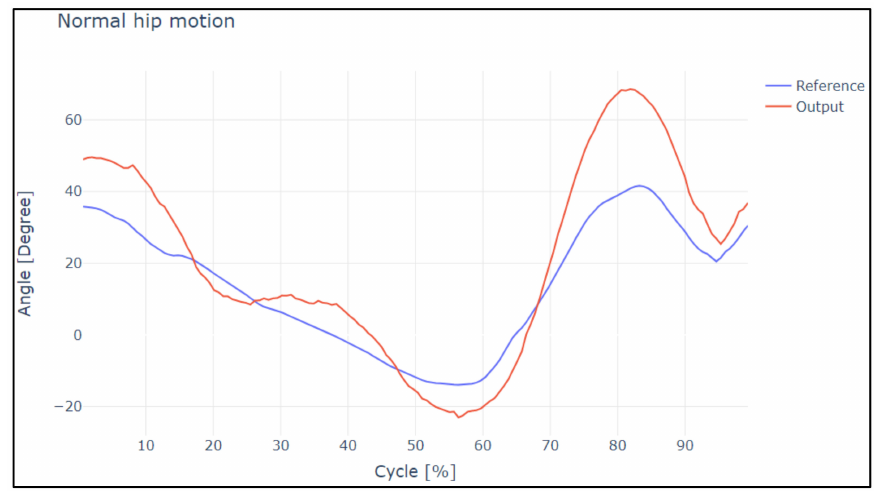
Figure 13. Reference curves vs. output during normal hip motion.